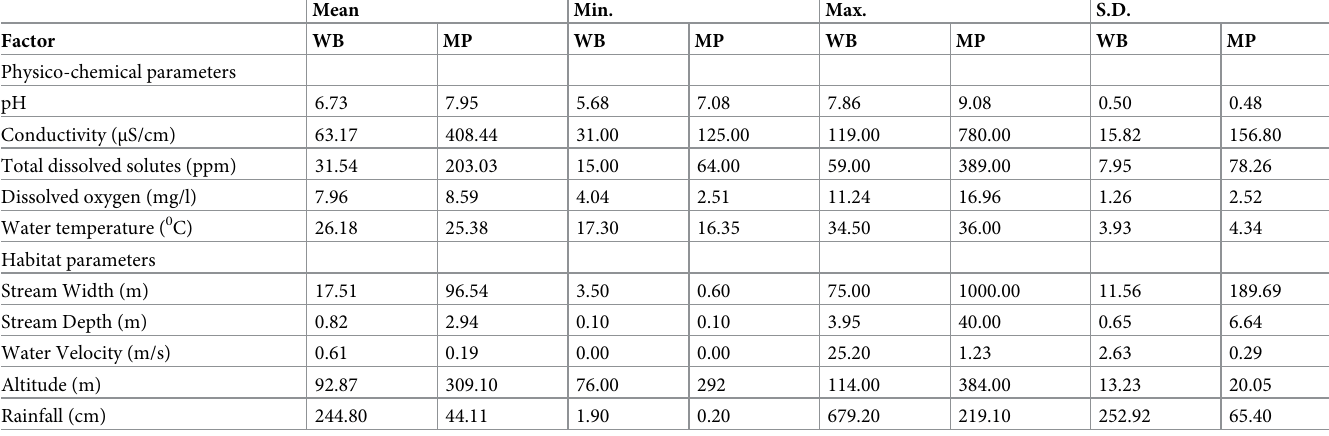
Table 3. Details of physico-chemical and habitat parameters measured at sampling locations in MP and WB- Mean, minimum (Min.), maximum (Max.) and stan- dard deviations (S.D.) are given in the table